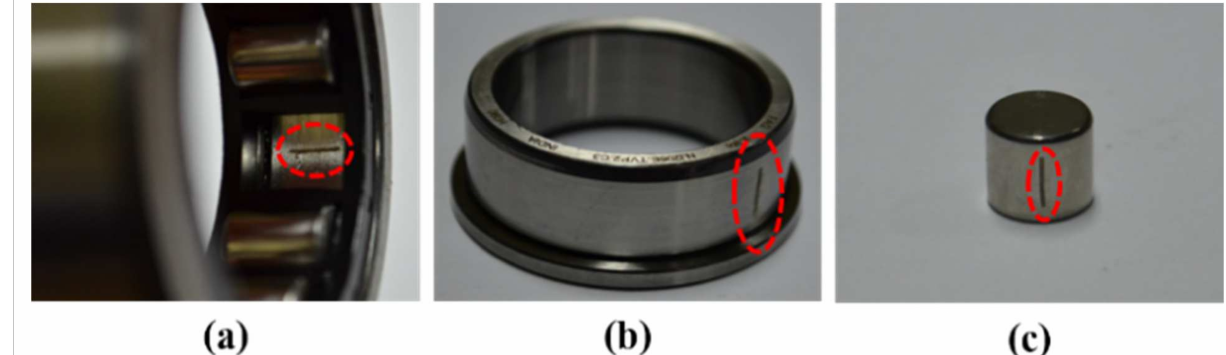
Figure 7. Fault types: ( a ) outer raceway type (ORT), ( b ) inner raceway type (IRT), and ( c ) roller type